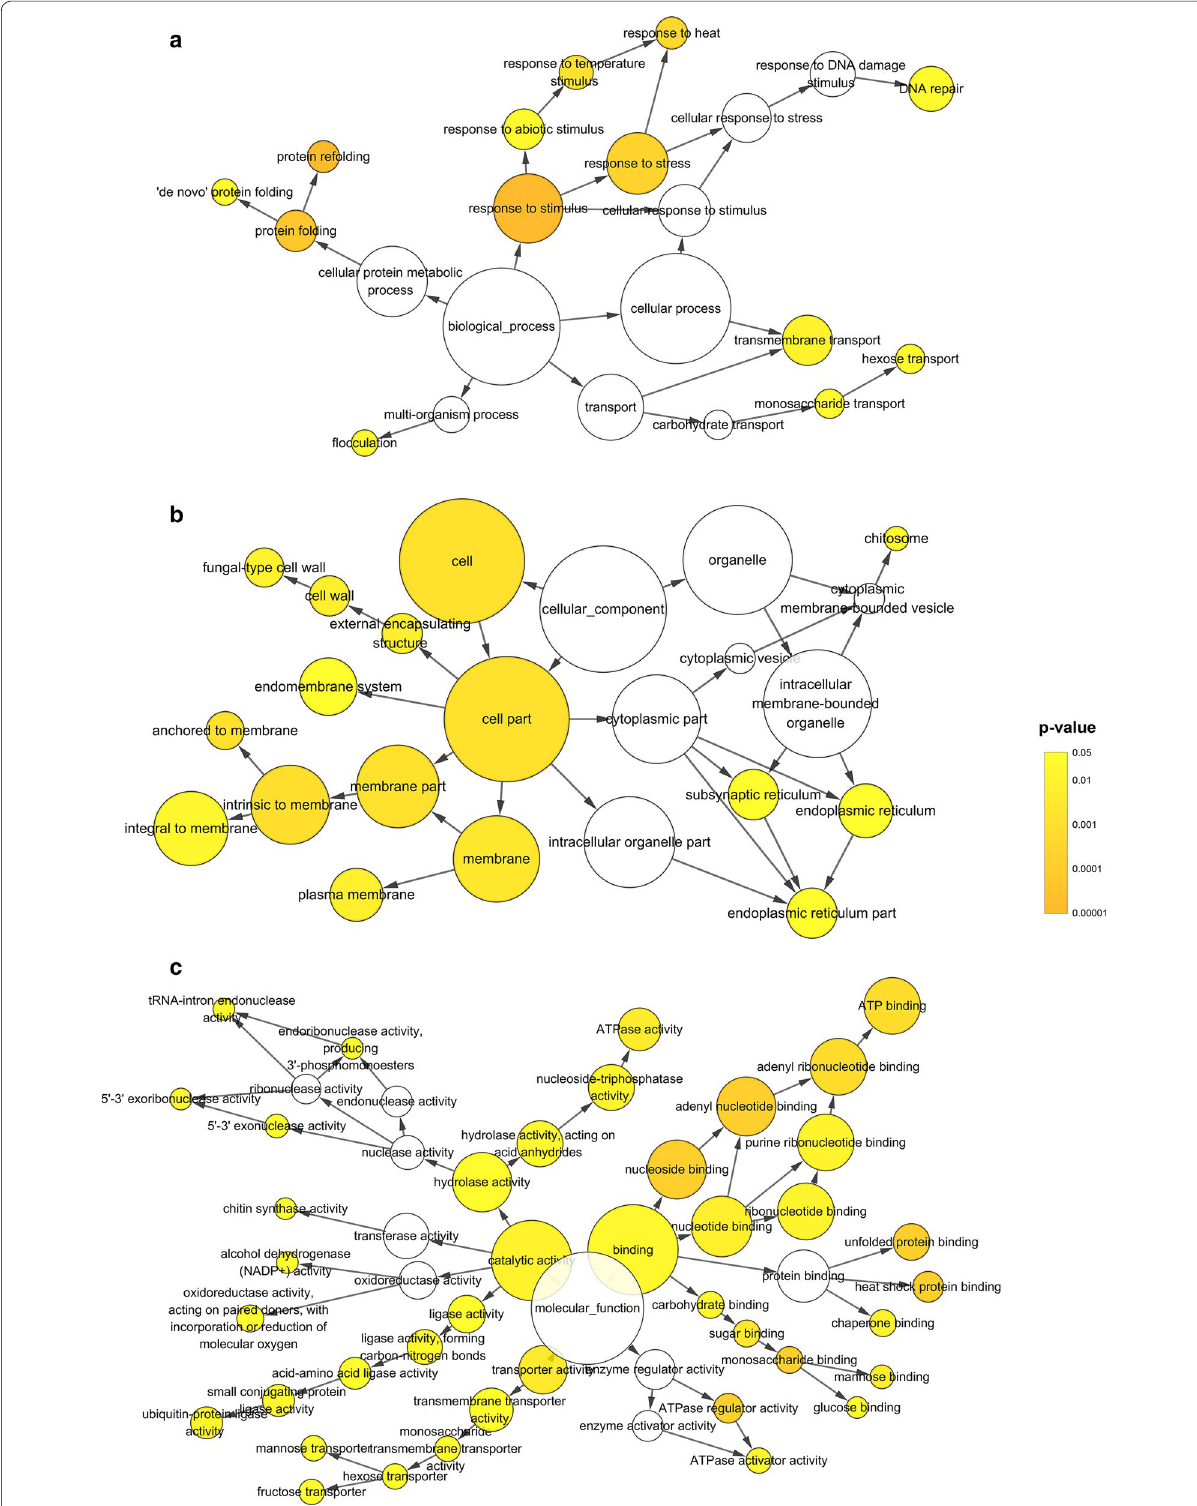
Fig. 6 Gene Ontology enrichment analysis using Cytoscape-BiNGO. The number of enriched DEGs in each GO category is proportional to node diameter. Darker nodes are associated with lower P -values. a Biological process. b Cellular component. c Molecular